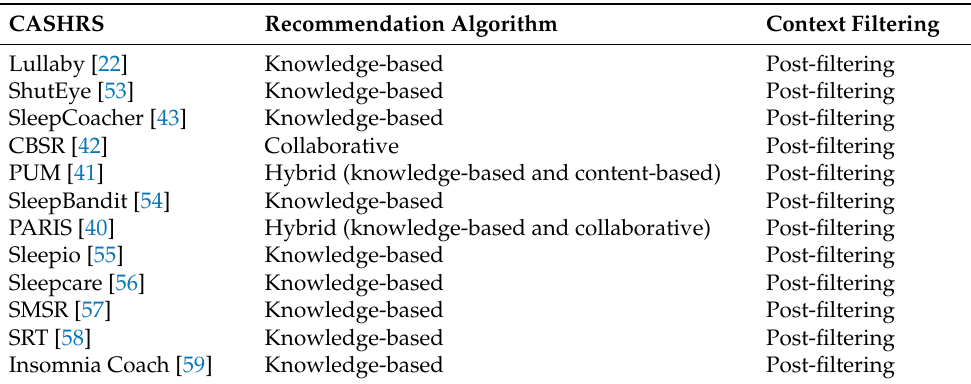
Table 3. Recommendation generation and context